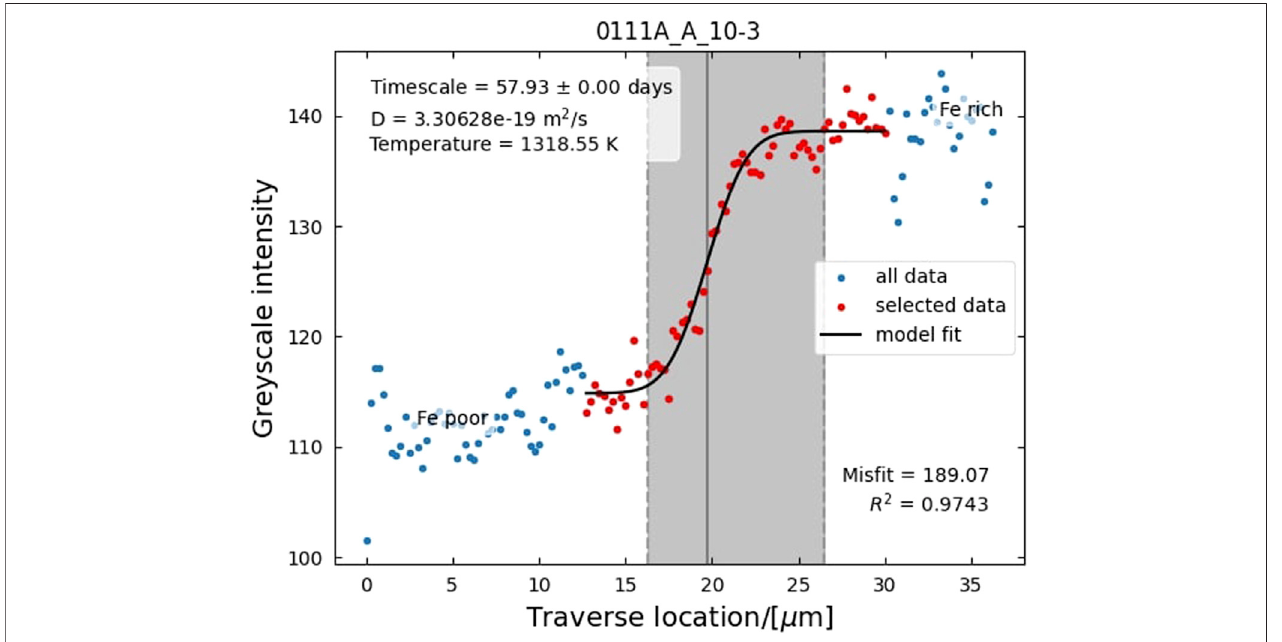
FIGURE 5 | SEM greyscale intensity as a function of traverse location extracted from the SEM image for a sample from the 1010 Cal. CE eruption (blue dots), the data selected for fi tting bythe model (red dots), and the model solution (black line). Also shown are the fi tted parameters (timescale, diffusion coef fi cient, D, and effective temperature), the theoretical pro fi le midpoint ( μ – gray line), and the “ goodness-of- fi t ” (R). The gray shaded area represents the mean ± 1 SD of the selected